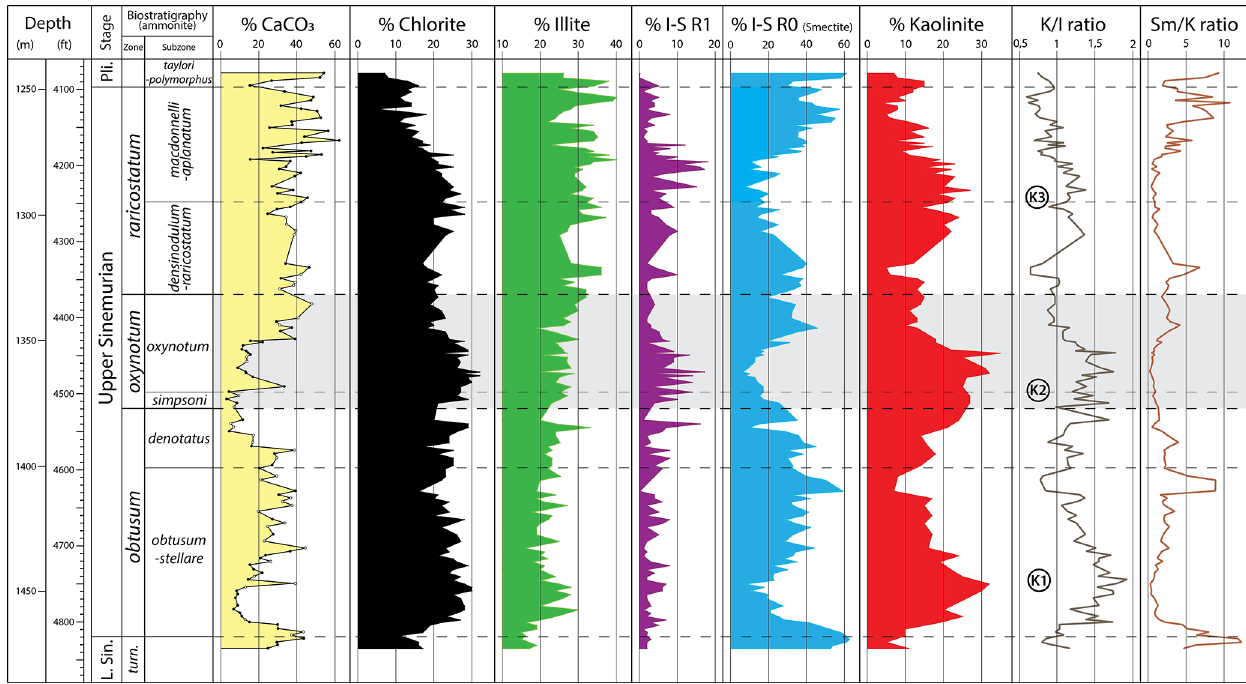
Figure 5. Calcite proportions and composition of the clay fraction of the upper Sinemurian strata of the Mochras borehole. Kaolinite / illite (K / I) and smectite / kaolinite (Sm / K) ratios correspond to the ratio of the areas of the main peaks of these minerals. L. Sin. – lower Sinemurian, Pli. – Pliensbachian, turn. = turneri